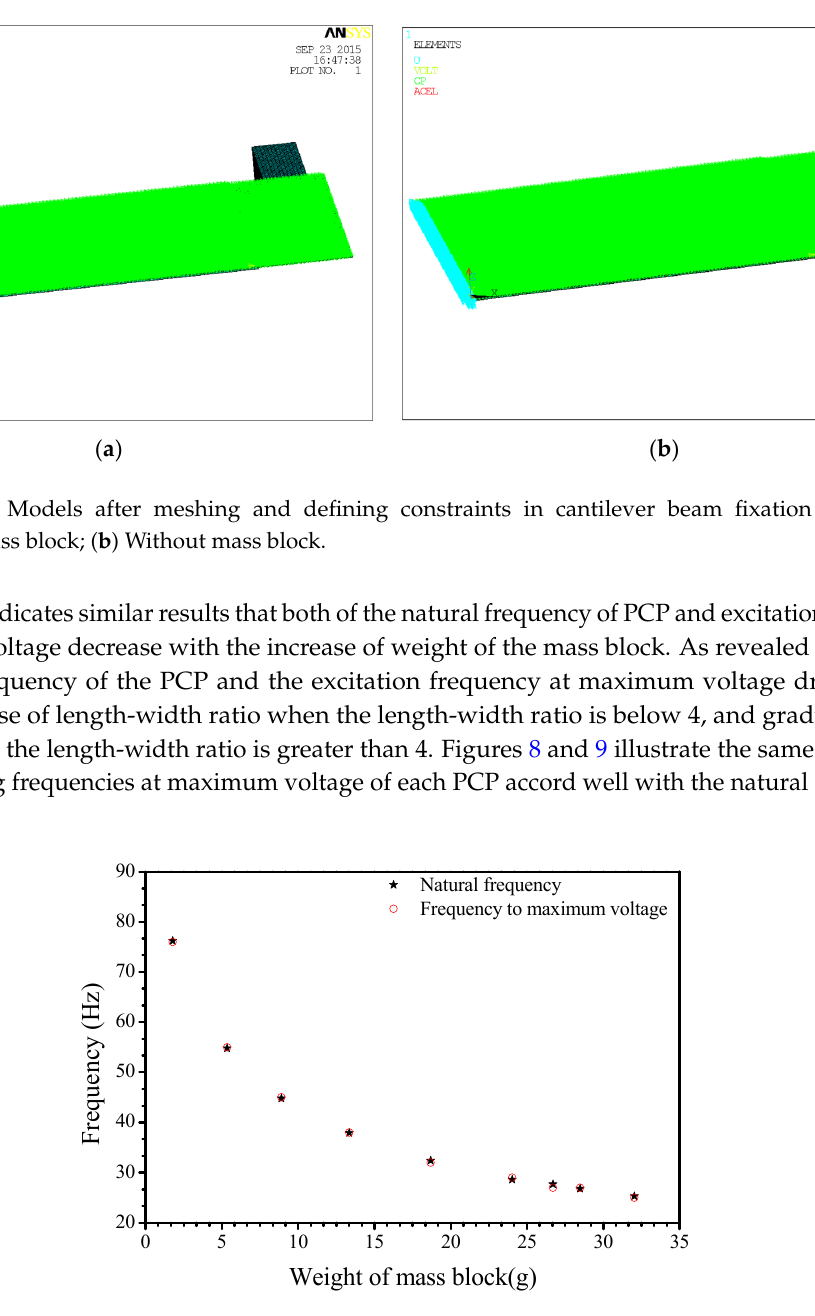
Figure 8. Weight of mass block versus natural frequency of PCP and exciting frequency at maximum voltage in cantilever beam fixation mode.